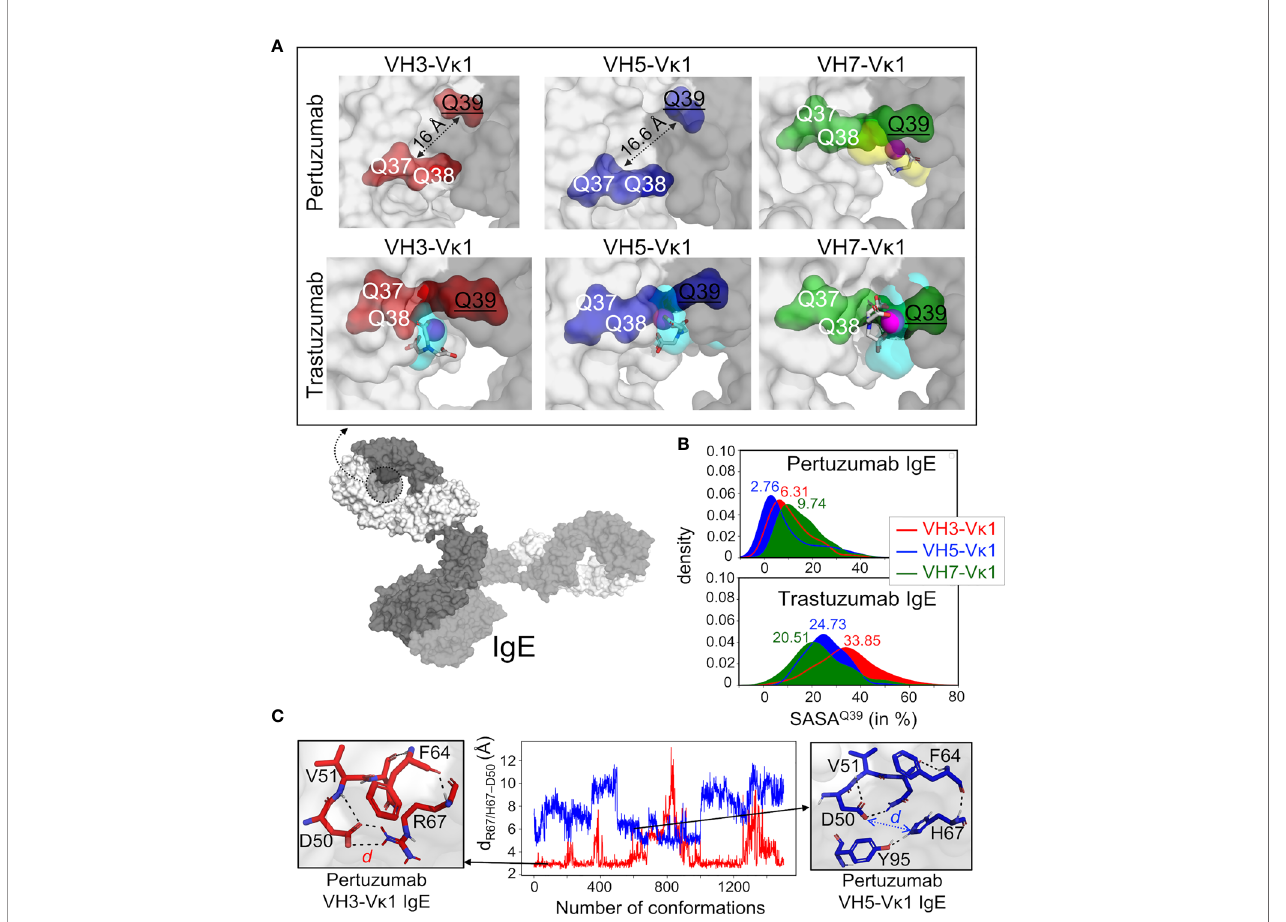
FIGURE 2 | Structural analyses of glutamine from Pertuzumab and Trastuzumab VH3, VH5, and VH7 IgE variants in binding Ni-NTA. (A) Model of whole IgE (L-chain in white surface and H-chains in gray surface) reveals the formed pocket at the VHx – V k 1 interface (dashed circle). The Ni-NTA bound region of the variants VH3 (red), VH5 (blue), and VH7 (green) shows the glutamine (Q) stretch constituted by the VH Q39 (underlined) and V k 1 Q37-Q38 to form a stable cryptic pocket (capacity of which is shown in cyan transparent surface) in the Trastuzumab IgE variants or a transient non-cryptic pocket (yellow transparent surface) in the Pertuzumab VH7. The bound Ni-NTA is shown in magenta spheres and interacts at the pocket in both Pertuzumab and Trastuzumab. (B) Relative solvent accessible surface area (SASA) of the Pertuzumab and Trastuzumab VH Q39 residue in all the variants to demonstrate the deeply buried Q39 (SASA< 10%) of the Pertuzumab variants. (C) Distance d between residue 67 (R67 in VH3 or H67 in VH5) and H-chain CDR2 D50 of Pertuzumab VH3-V k 1 IgE (red) and VH5-V k 1 IgE (blue) during the simulation. Structural visualizations were generated using PyMOL 2.3.2 (46). An augmented reality (AR) presentation of the Ni-NTA binding to Trastuzumab VH5 IgE glutamine-forming pocket could be viewed using our ‘‘ APD AR Holistic Review ’’ app available on both Google and Apple app stores [for more details see ref (47,